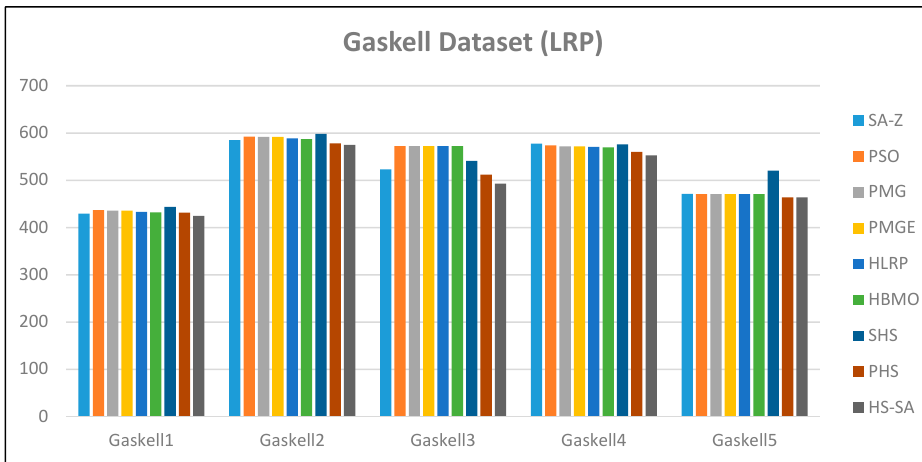
Figure 4. Best result of Gaskell dataset for LRP.